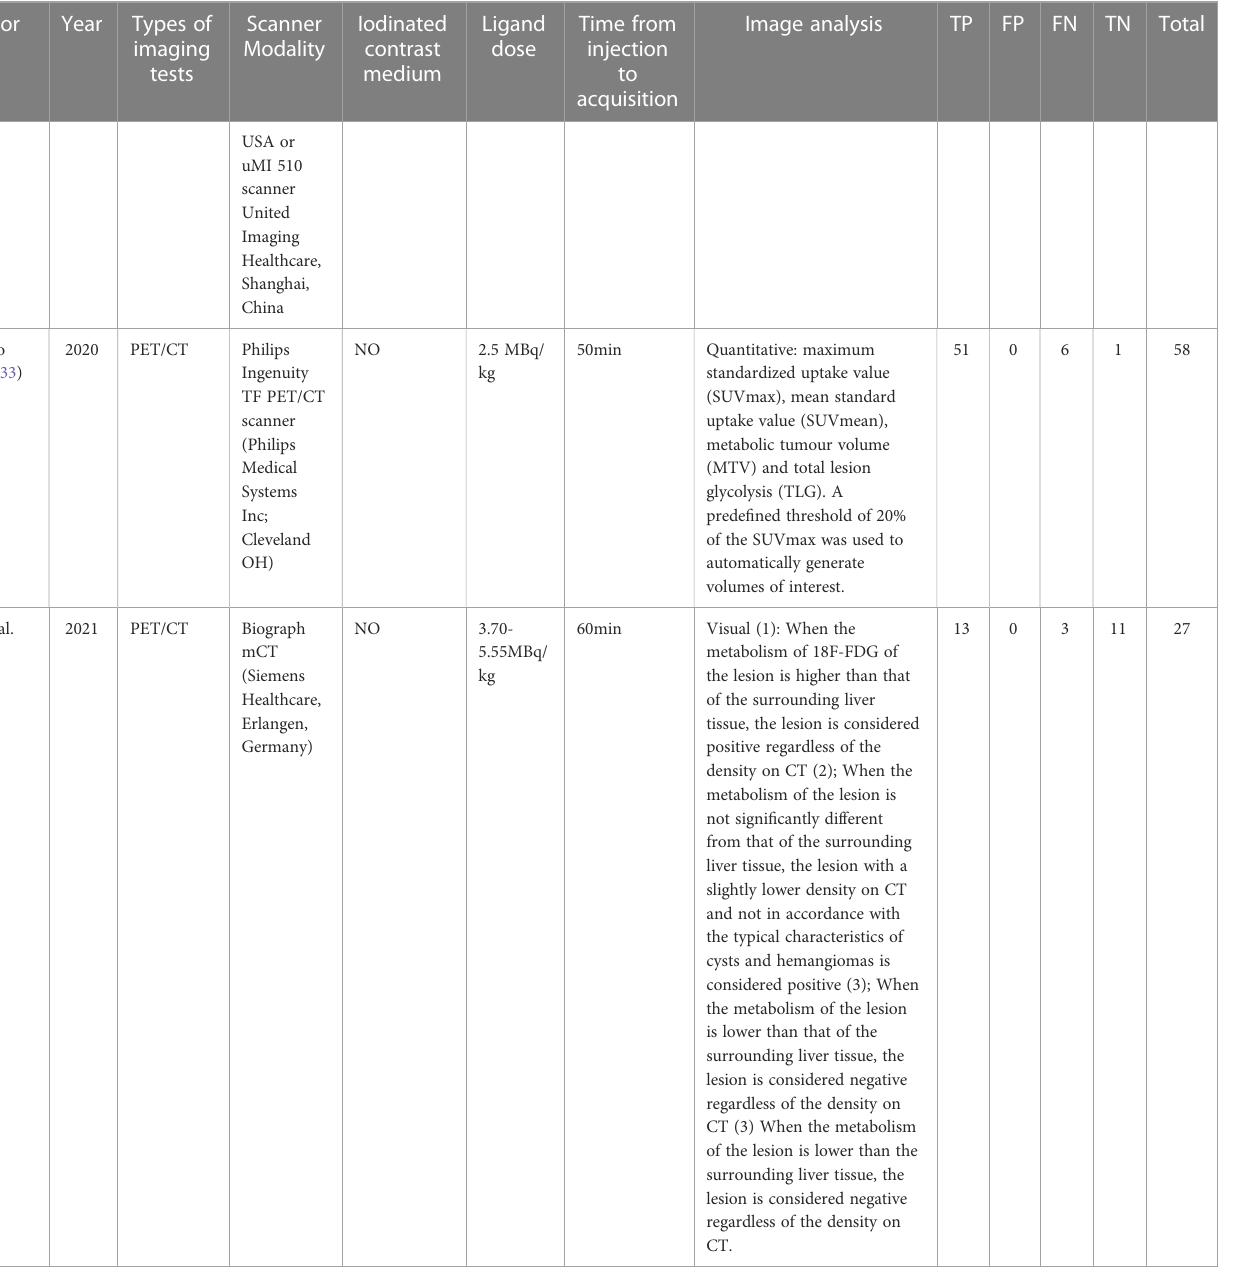
signi fi cantly ( P = 0.27). Figure 5 illustrated the SROC curve for [18F]FDG PET/CT and [18F]FDG PET/MRI, which exhibited